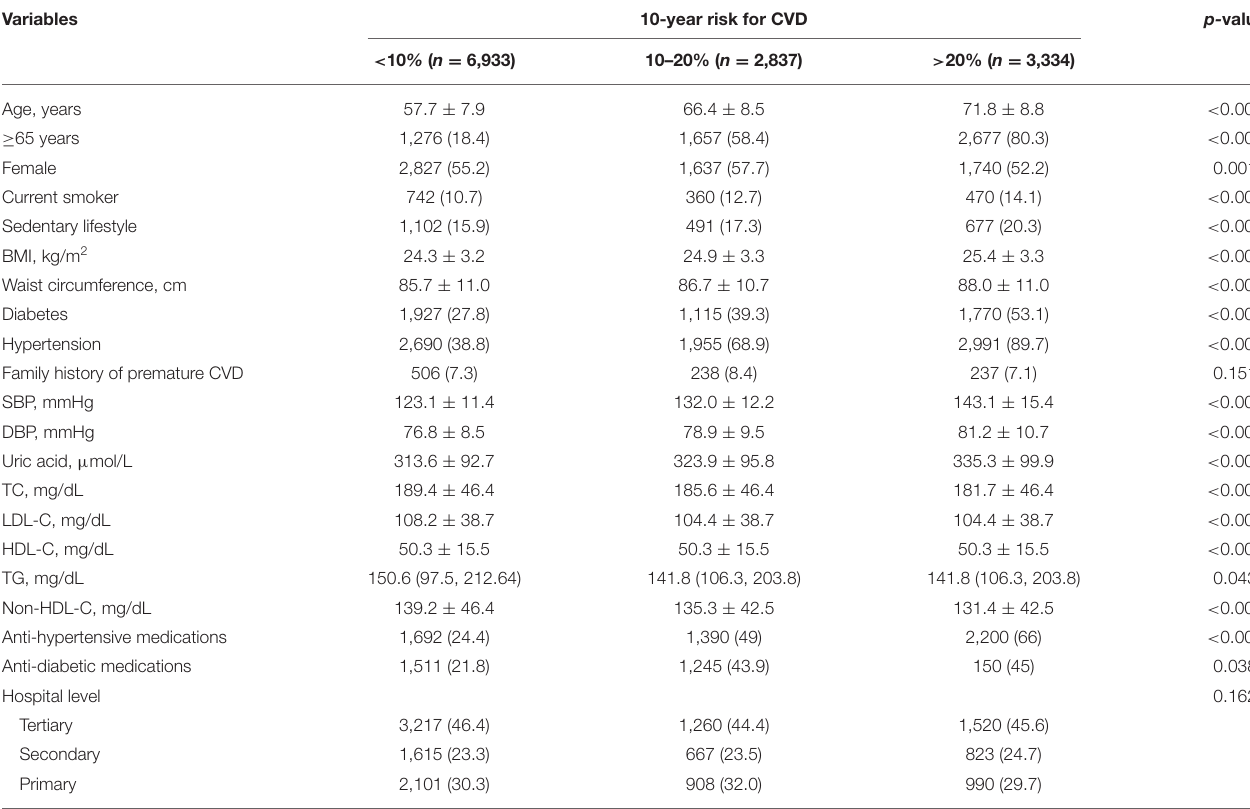
TABLE 1 | Characteristics based on 10-year risk for CVD.